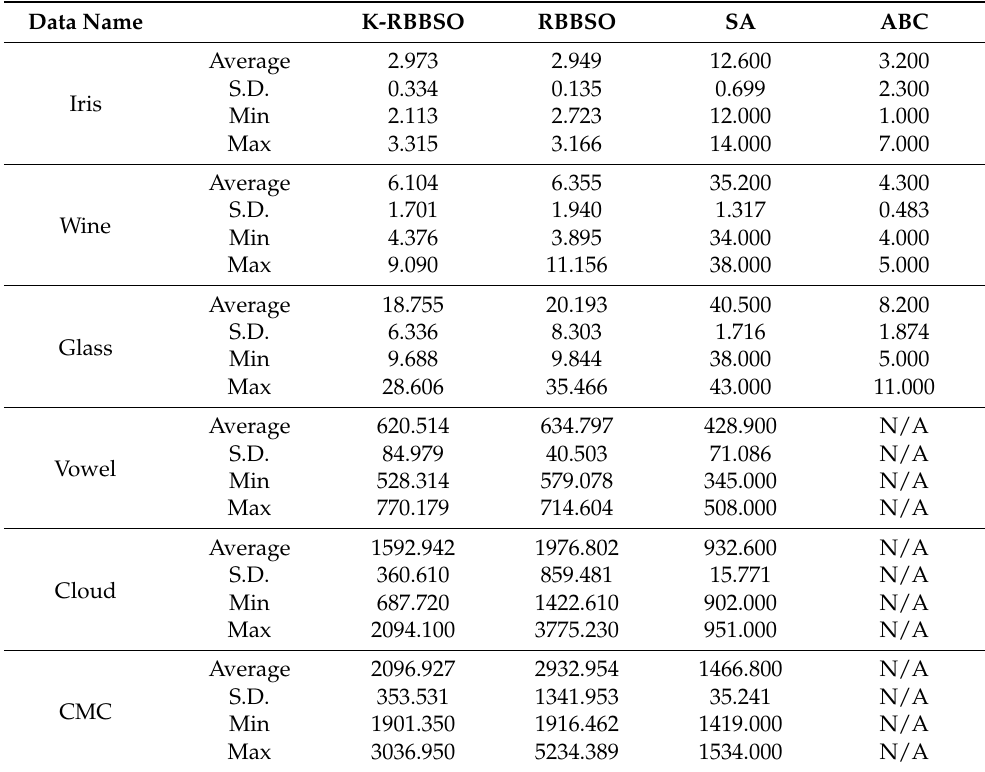
Table 3. Results of calculation